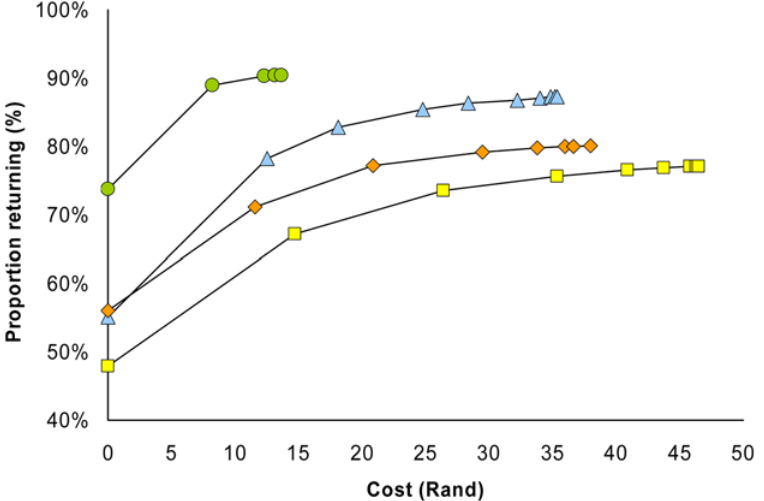
Figure 2. Relationship between increased attendance and additional cost. Shown in the graph are the response functions relating the additional cost of policies allowing greater number of CHW home visits per woman to increases in appointment attendance. Separate functions are shown for 6-month appointments (green circles), 12-month appointments (blue triangles), 24-month appointments (yellow squares), and 36-month appointments (orange